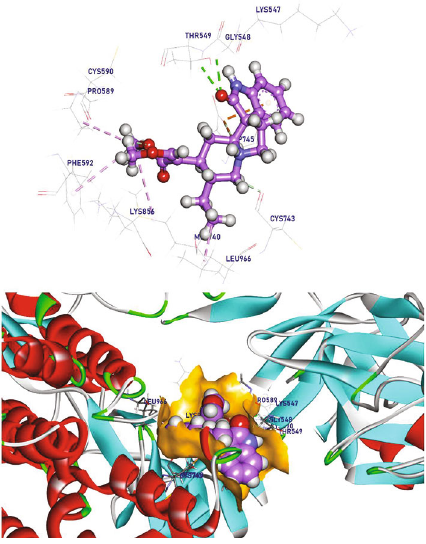
Figure 14: Rhynchophylline docked in RBD-SARS-CoV-2 Omicron spike protein, hydrogen bonds (green), and the pi interactions are represented in purple